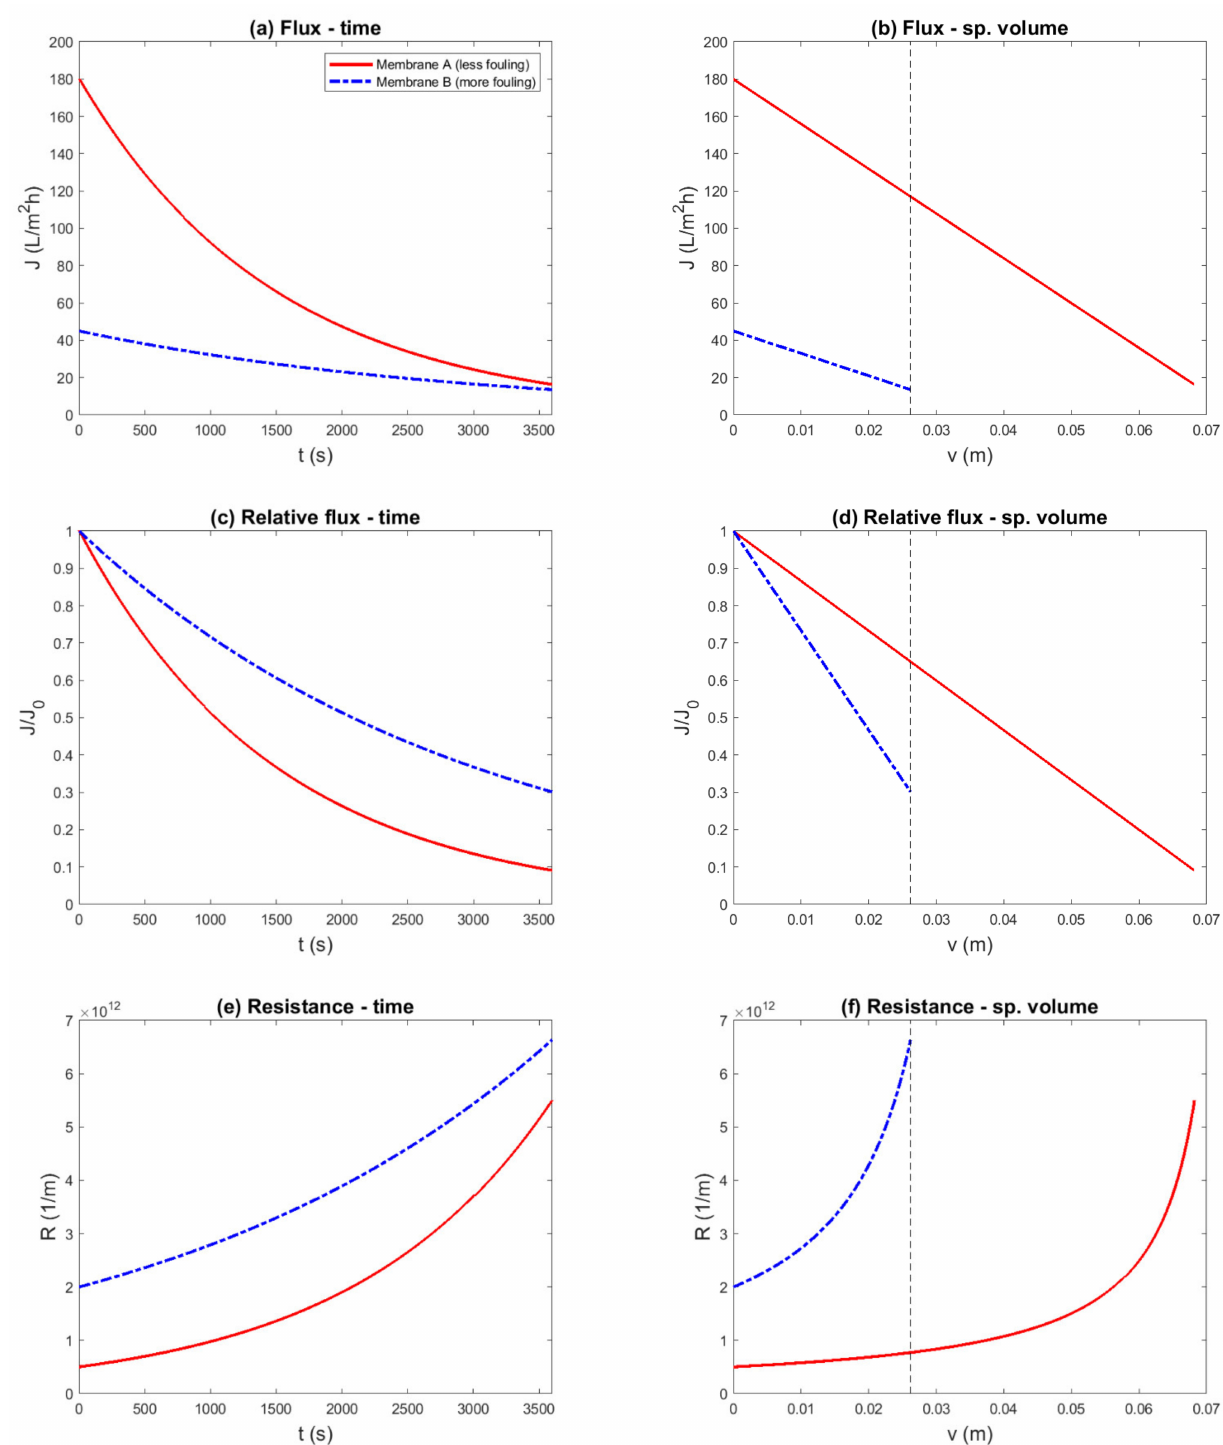
Figure 7. Comparison between two membranes for a single constant-pressure (0.25 bar) run with different representations of the data. The example was constructed such that membrane A was superior to membrane B, due to both a lower membrane resistance ( R MA = 0.5 × 10 12 m − 1 vs. R MB = 2.0 × 10 12 m − 1 ) and a lower fouling rate ( v xA = 0.075 m vs. v xB = 0.0375 m). Different representations ( a —Flux–Time; b —Flux–Specific Volume; c —Relative Flux–Time; d —Relative PerFlux–Specific Volume; e —Resistance–Time; f —Resistance Change–Specific Volume) were compared to evaluate if the known difference in fouling propensity was correctly reflected: Relative flux vs. time ( c ) and resistance vs. time ( e ) suggest a conclusion contradicting the underlying